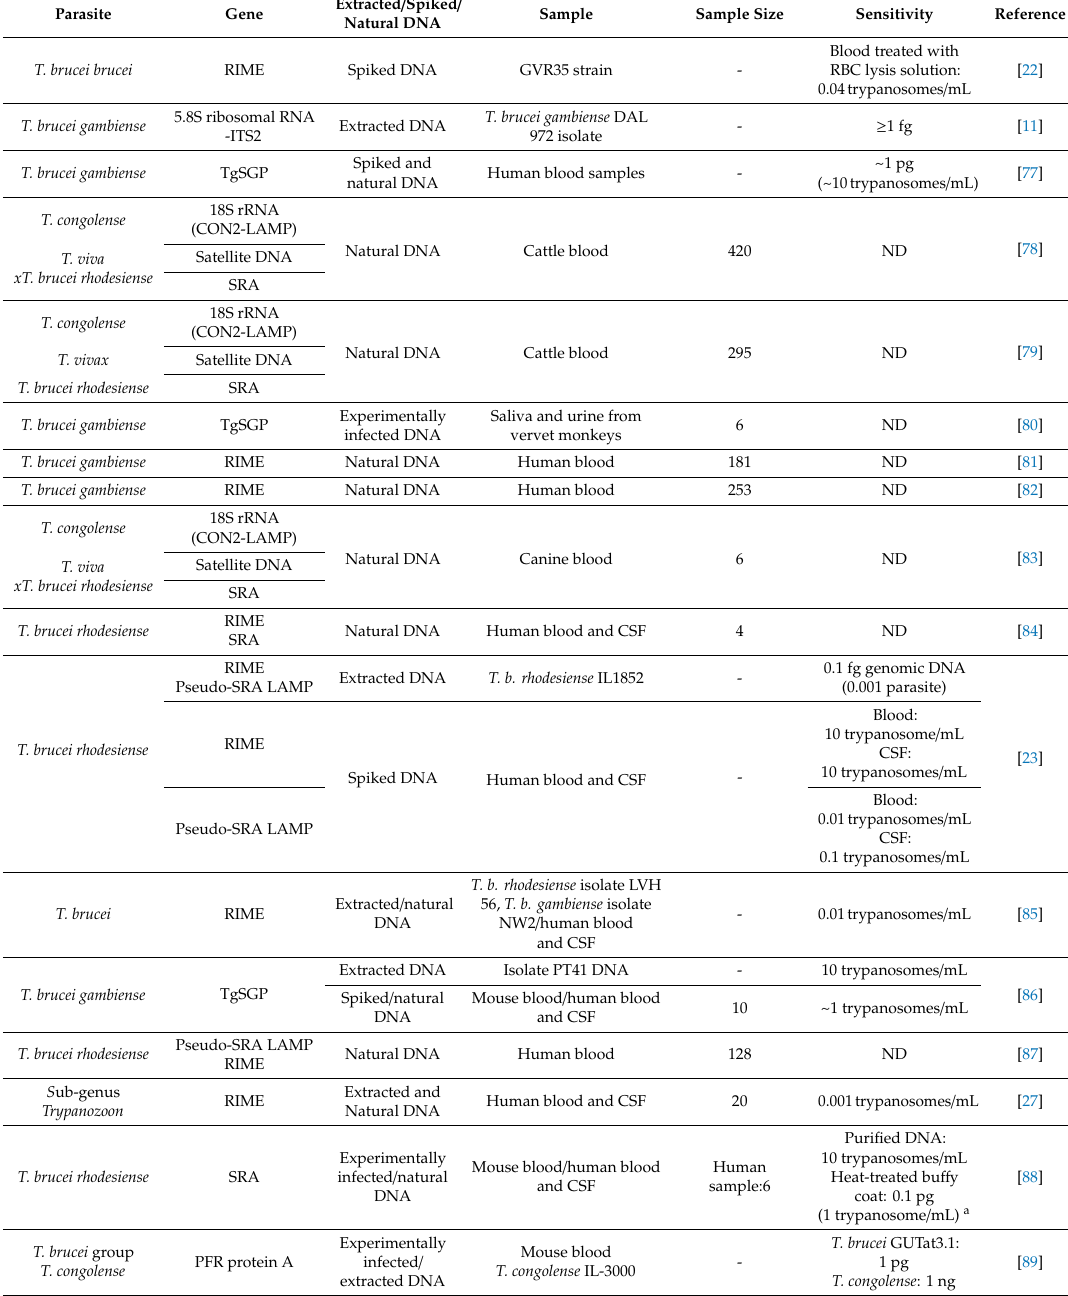
Table 6. Publications found in the US National Library of Medicine National Institutes of Health (NCBI-PubMed) reporting the standardisation of the LAMP technique as a useful tool for diagnosing HAT (sleeping sickness) in the definitive